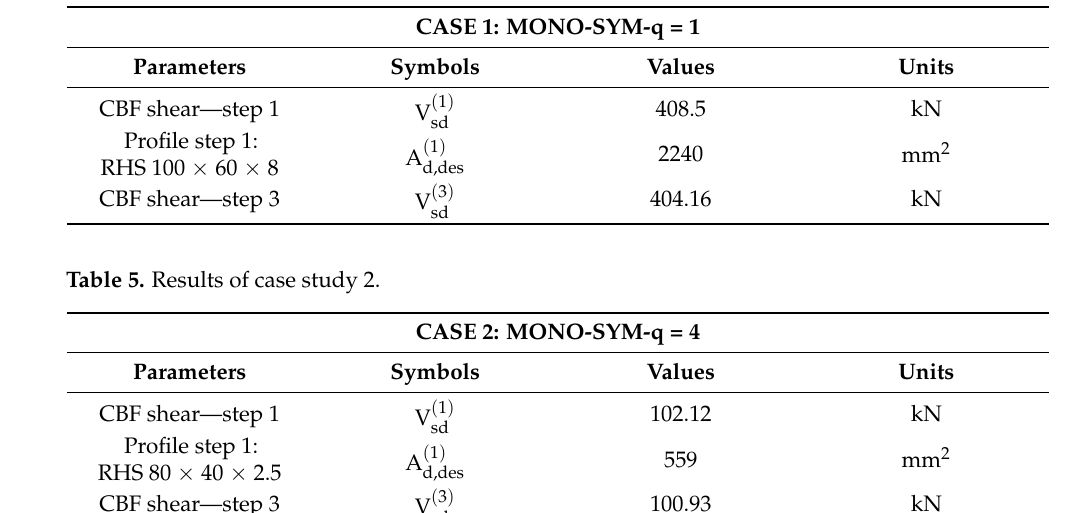
Figure 12. Mono-storey building model with SAP2000 for case studies 1 and 2. Table 4. Results of case study 1.